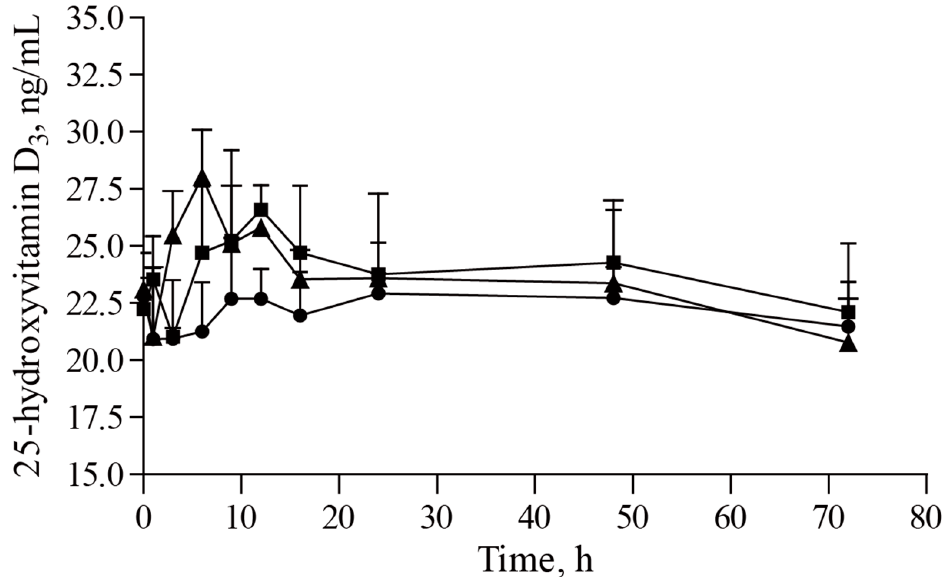
Figure 2. The plasma concentration of 25-hydroxyvitamin D 3 versus time. The concentration of 25-hydroxyvitamin D 3 in plasma from 0 to 72 h after oral placebo ( ● ), non-microencapsulated vitamin supplement ( ▪ ), and microencapsulated vitamin supplement ( ▲ ), respectively. Error bars represent standard deviations.